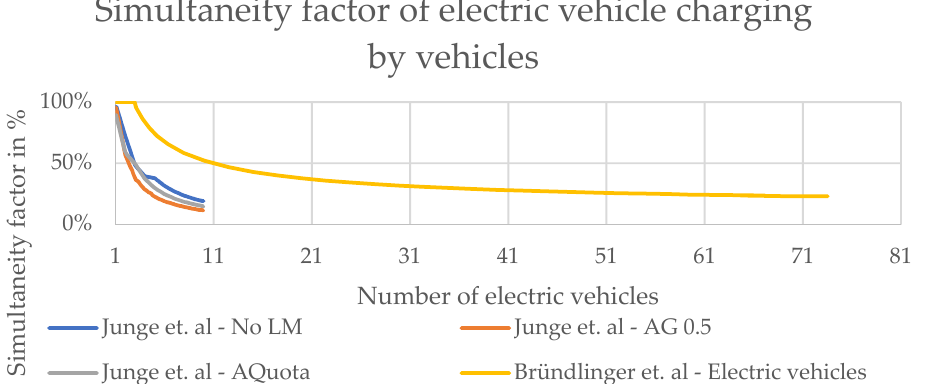
Figure 2. SFs reported in the literature by Junge et al. [12] (three scenarios) and by Bründlinger et al. [18] for electric vehicle charging. An SF of 100% was equivalent to all observed vehicles charging simultaneously at one moment in time. For a description of the individual scenarios, please refer to the linked studies.